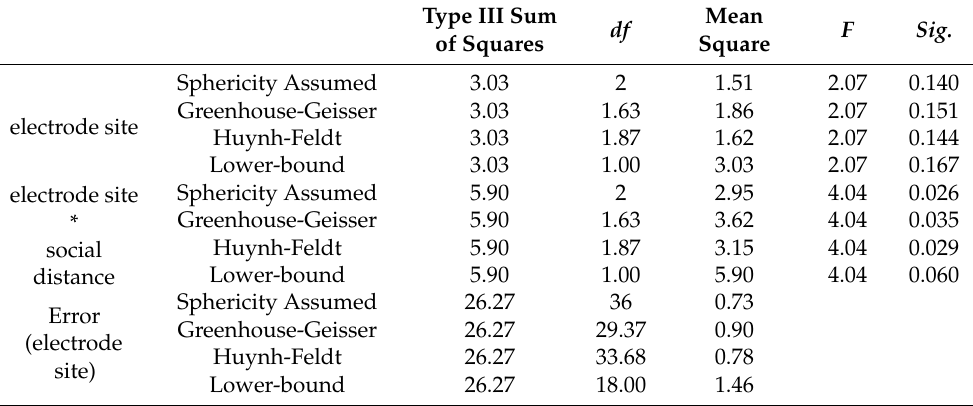
Table 8. Test of Within-Subjects Effects of N1 amplitude (prevention focus).